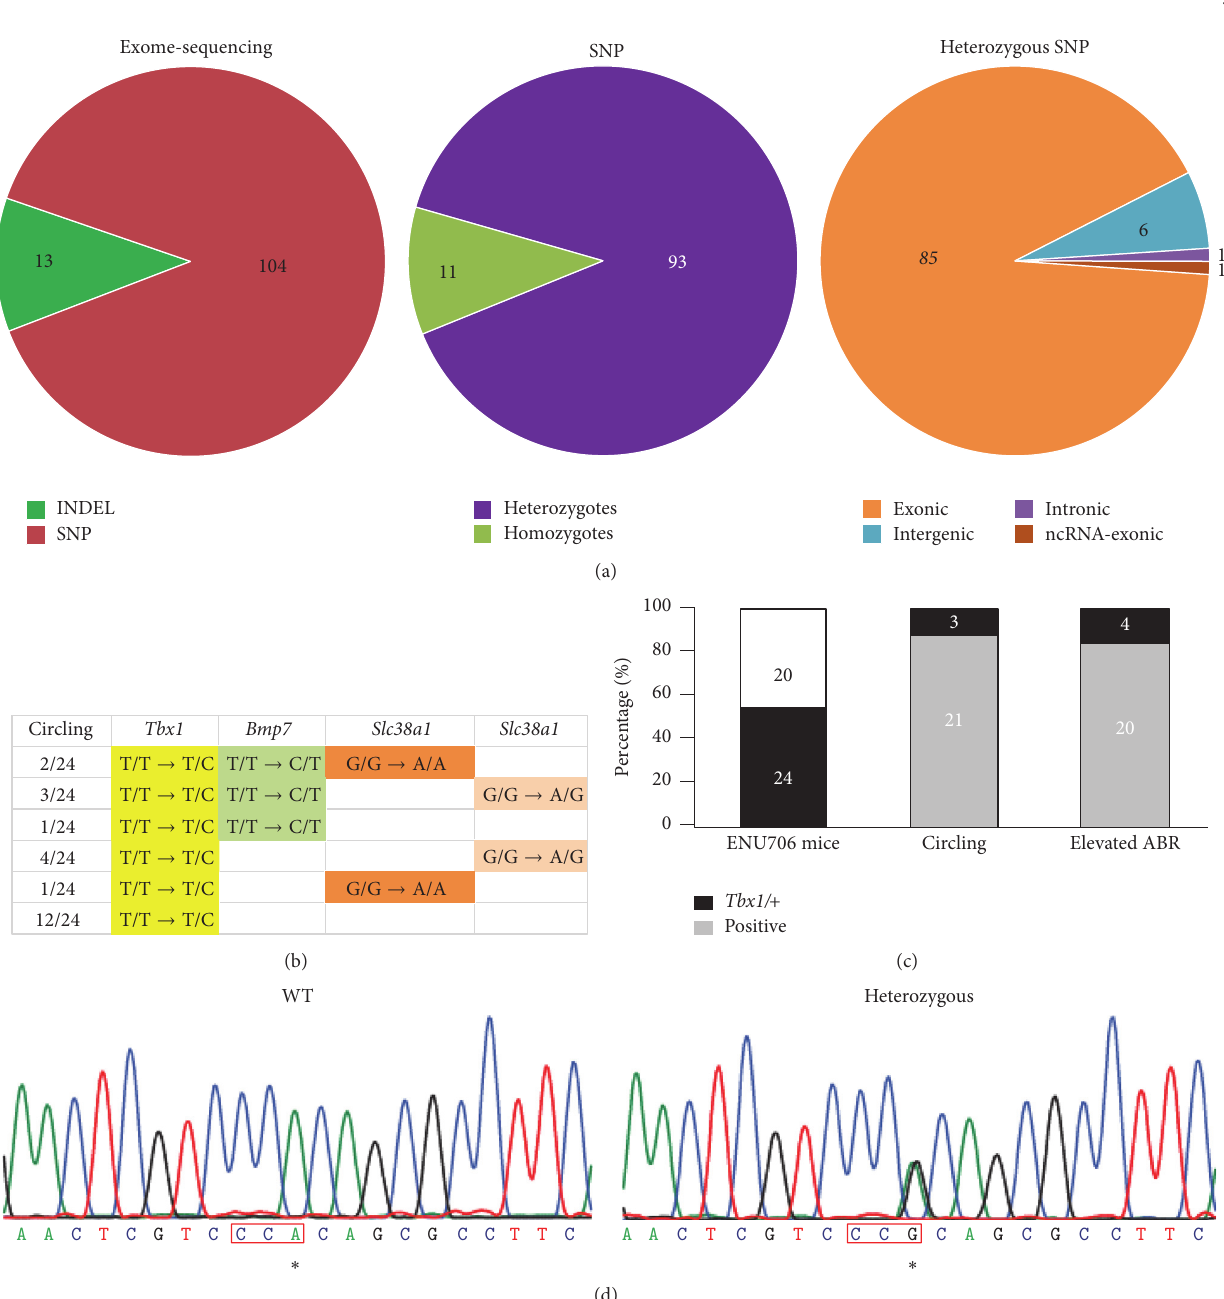
Figure 4: Genetic analysis of target gene in ENU706 phenotypes. (a) Whole genome sequence identified 104 SNPs in one circling ENU706 mutant mouse, among which 93 SNPs were heterozygous and 85 SNPs were exonic. (b) Top 3 candidate genes were Tbx1 , Bmp7 , and Slc38a1 . The T-to-C mutation in Tbx1 had the high penetration in ENU706 heterozygous mice with the circling phenotype. (c) The genotyping for the T-to-C mutation in Tbx1 showed there were 24 heterozygous mice out of all the 44 mice in this colony. And phenotypic assays showed 21 ENU706 heterozygous mice were circling and 20 ENU706 heterozygous mice had elevated ABR in all the 24 Tbx1 +/ − mice. (d) A typical DNA chromatogram showing the T-to-C mutation in an ENU706 heterozygous mouse. Note a reverse primer was used for sequencing. ∗ refers to the T-to-C